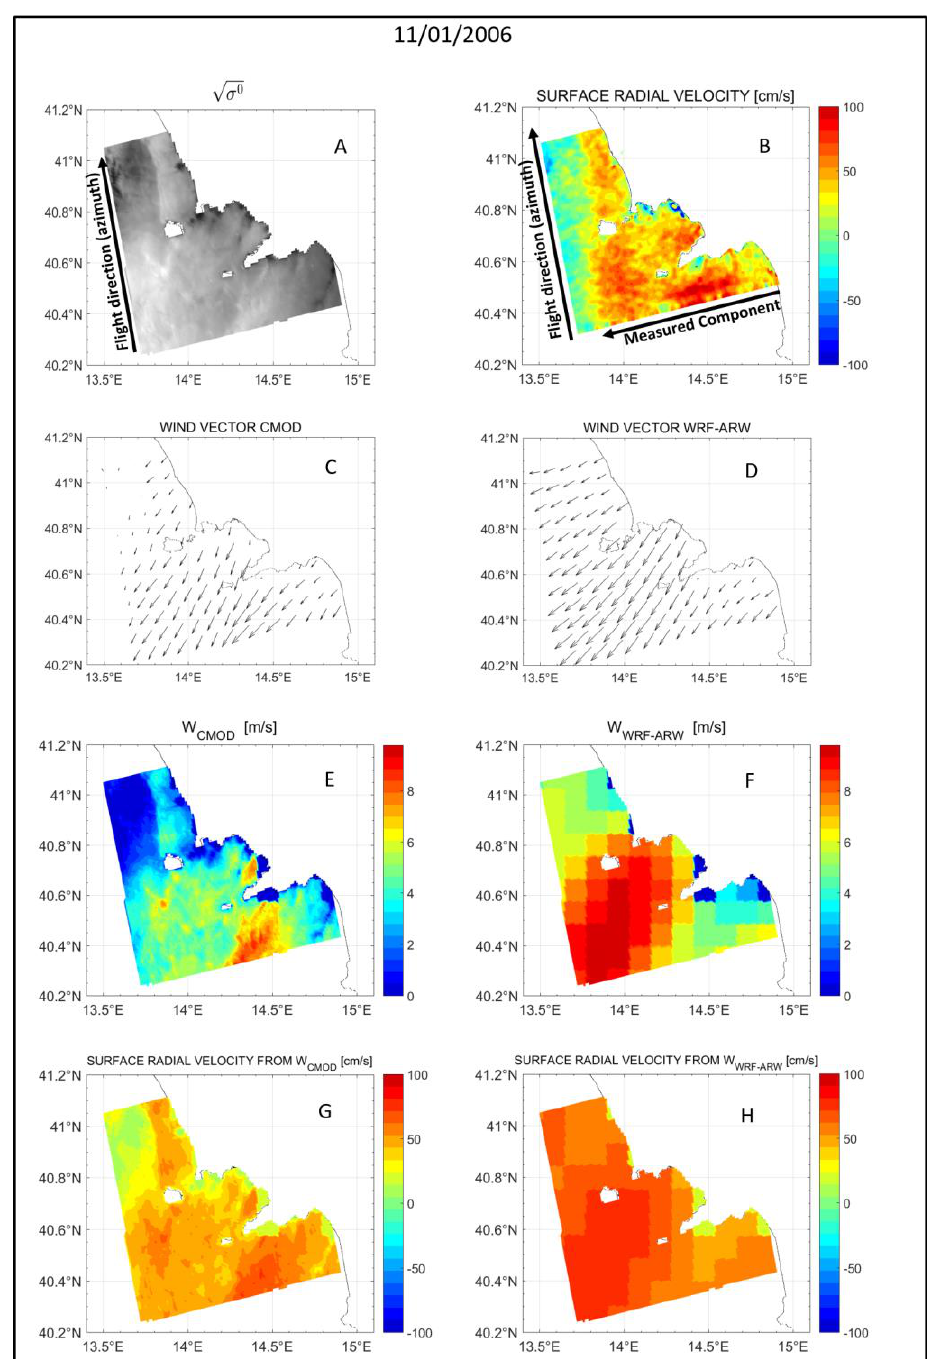
Figure 9. Results related to the acquisition of 11/01/2006. The image is divided as follow: ( A ) is the 𝜎 0 ; ( B ) is the estimated Doppler Anomaly maps of the marine area converted into the line-of-sight component of the sea surface velocity; ( C ) is the wind direction obtained from the CMOD model; ( D ) is the wind direction obtained from the WRF-ARW model; ( E ) is the wind speed relative to the CMOD model; ( F ) is the wind speed relative to the WRF-ARW model; ( G ) and ( H ) is the surface radial velocity due to the wind component, evaluated as descried in Section 4, for the CMOD model and for the WRF-ARW model, respectively.